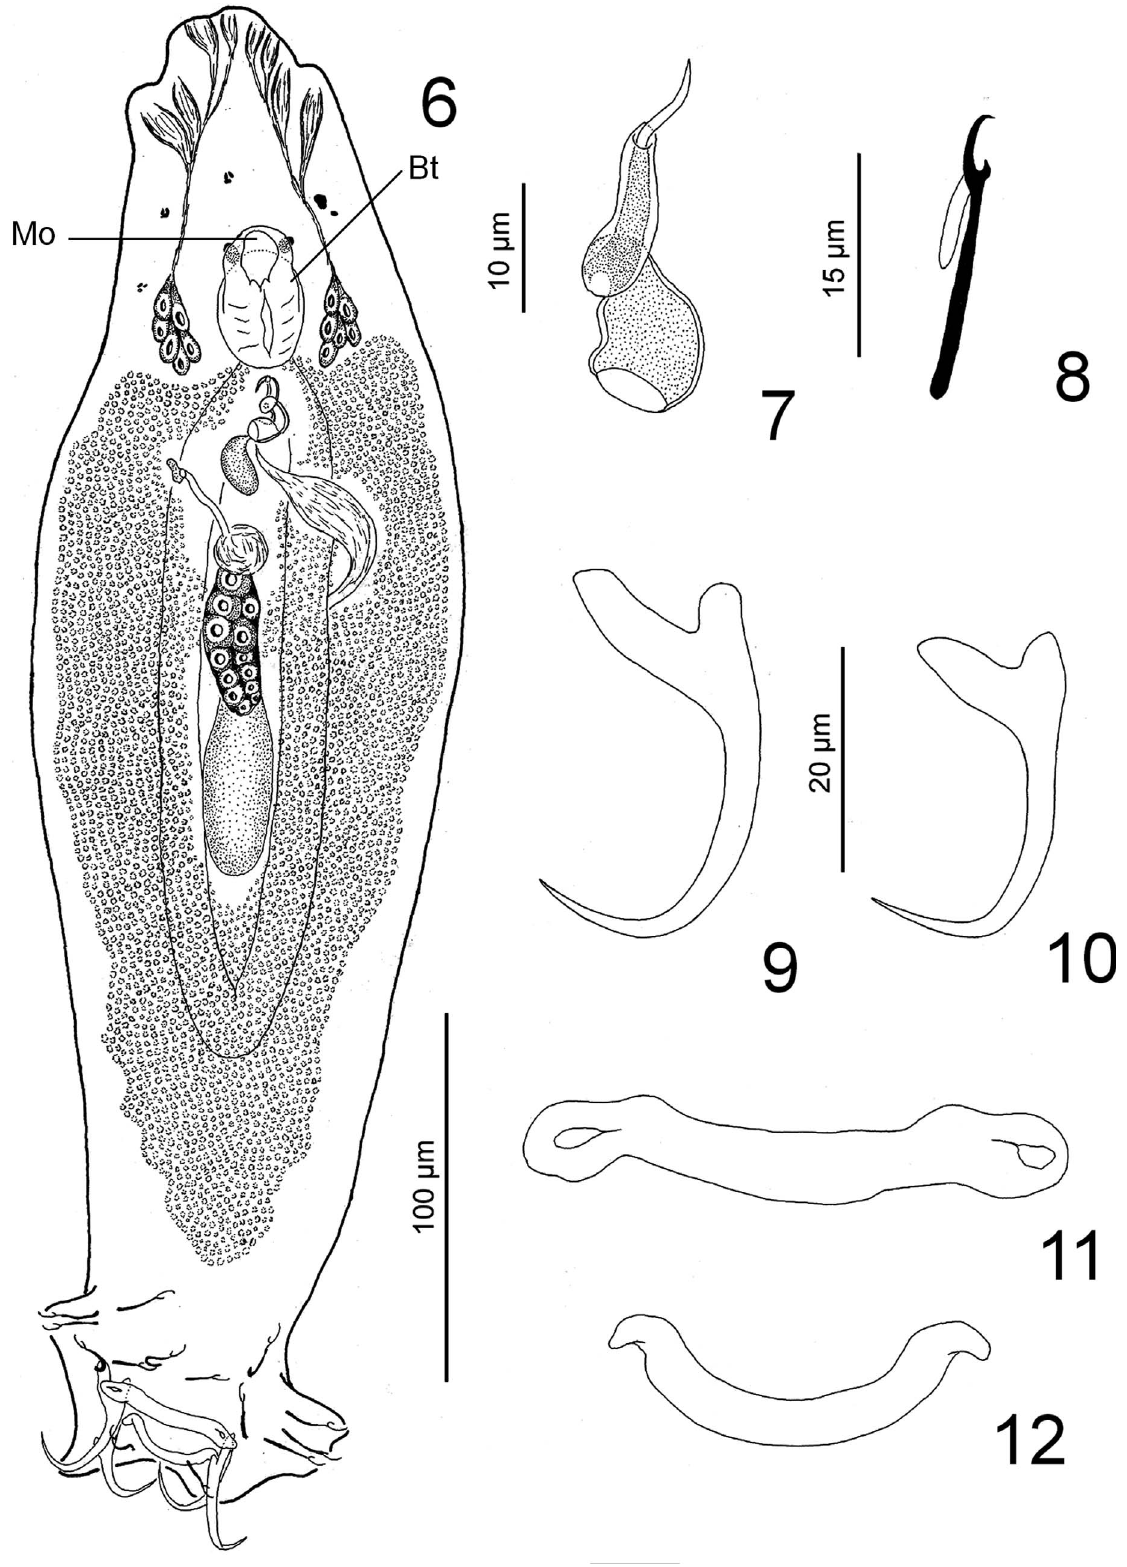
Figures 6–12. Ancyrocephalus chiapanensis n. sp. from the gills of Strongylura hubbsi . 6: whole-mount (composite, ventral view); 7: copulatory complex; 8: hook; 9: ventral anchor; 10: dorsal anchor; 11: ventral bar; 12: dorsal bar. Figures are drawn to the following scales: 100 l m (Fig. 6), 10 l m (Fig. 7), 15 l m (Fig. 8) and 20 l m (Figs.